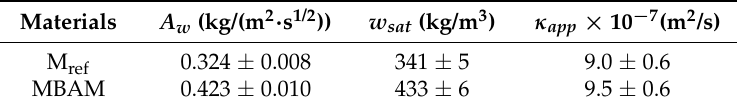
Table 7. Water transport properties.